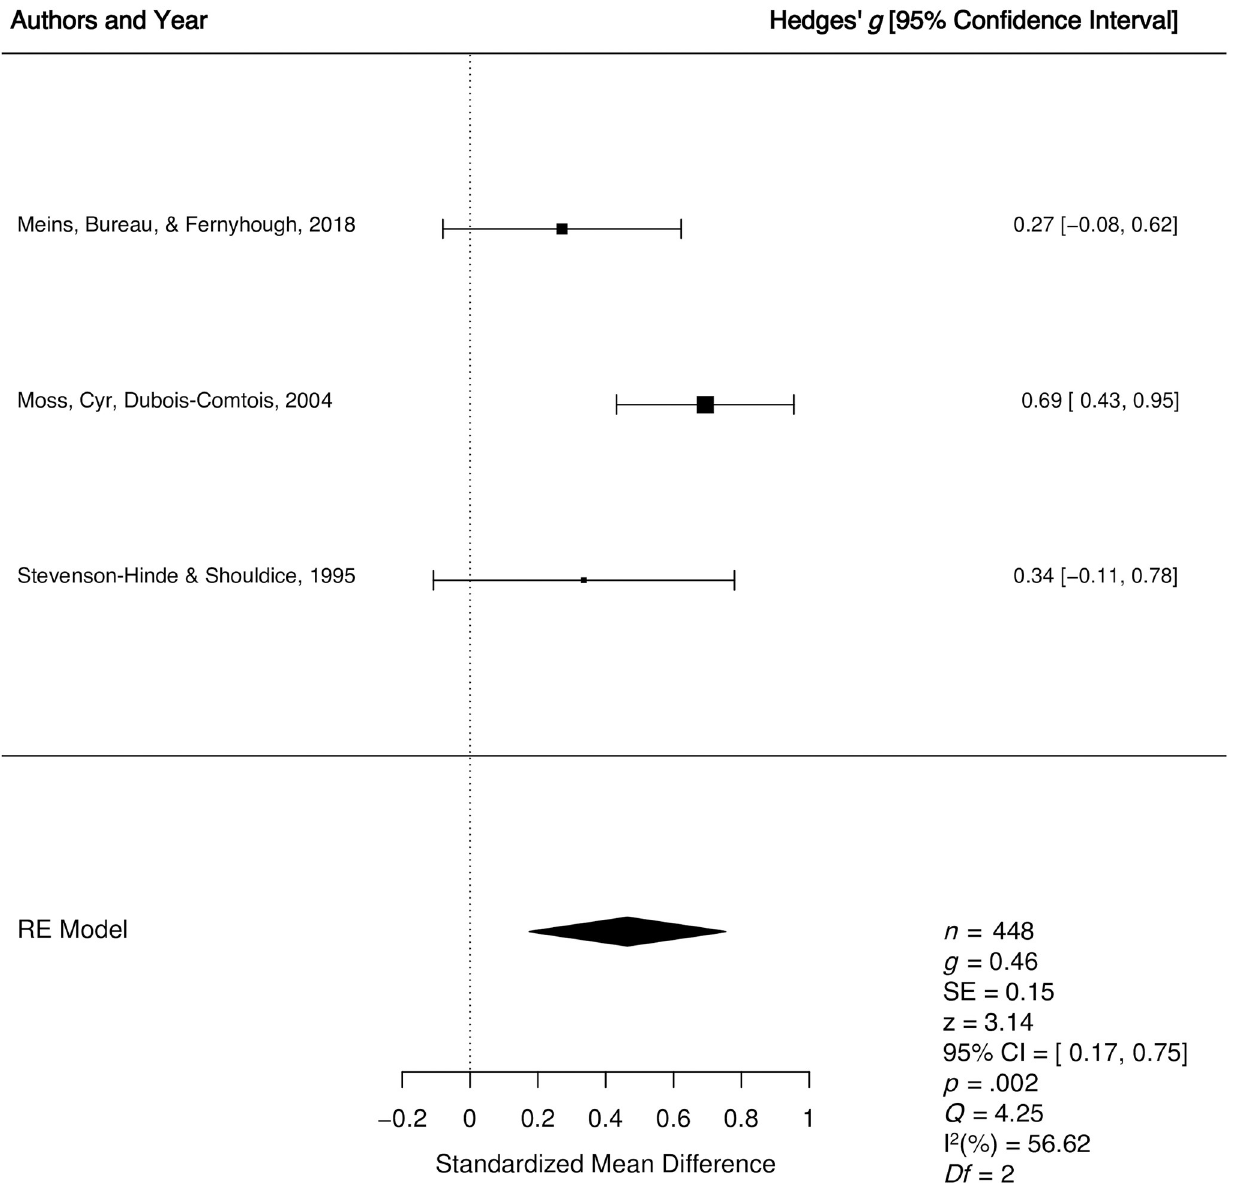
Fig 3. Forest plot for the longitudinal relationship between unidimensional caregiver sensitivity and secure versus insecure preschool attachment. RE = Random Effects Model; g = Hedges’ g; Q = Cochran’s heterogeneity statistic; I 2 = percentage of variability across studies that is due to between-study